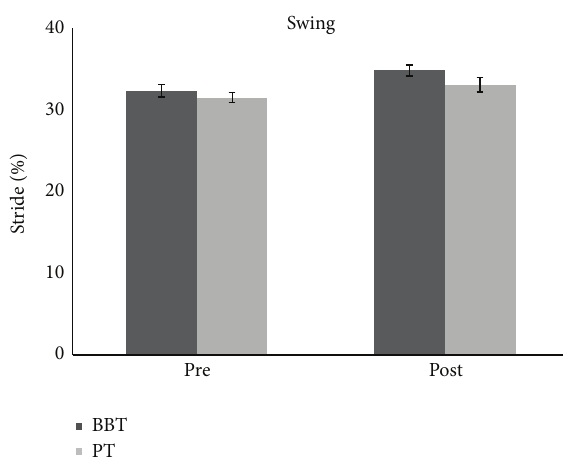
Figure 1: The graph shows the effects of BBT and PT (dark grey and lightgrey,resp.)onpercentageofdoublestancephasewithrespectto entire stride phase. Error bars indicate the standard error. ∗ 𝑝 < 0.05 . PT: physical therapy; BBT: blindfolded balance training.